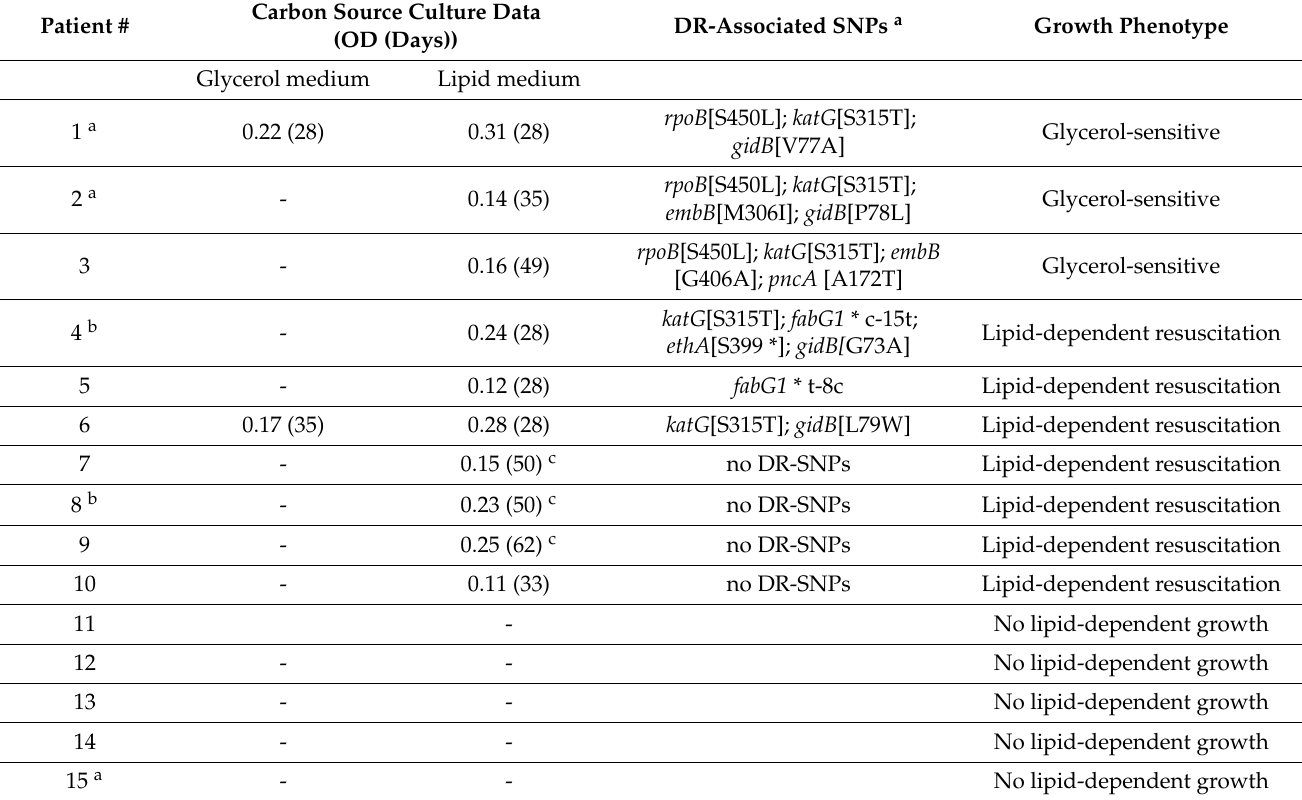
Table 3. Carbon source culture results and analysis of drug-resistance (DR)-associated SNPs for 15 Sm+/Cx − samples. MDR-TB: multidrug-resistant tuberculosis; OD: optic density; SNP: single-nucleotide polymorphism. Patient